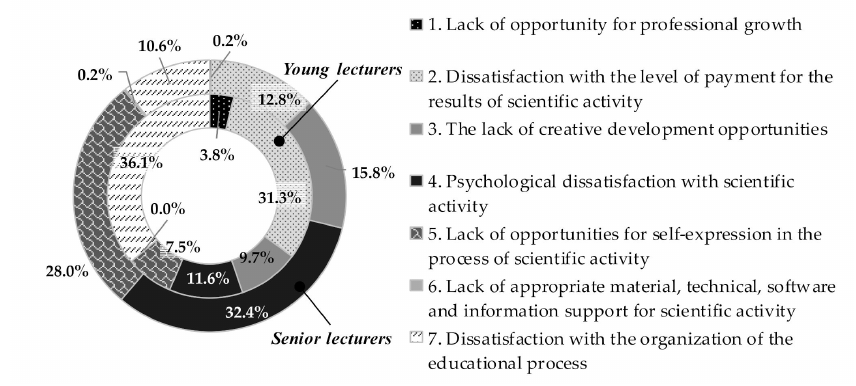
Figure 1. The distribution of the reasons for the decrease in the scientific activity